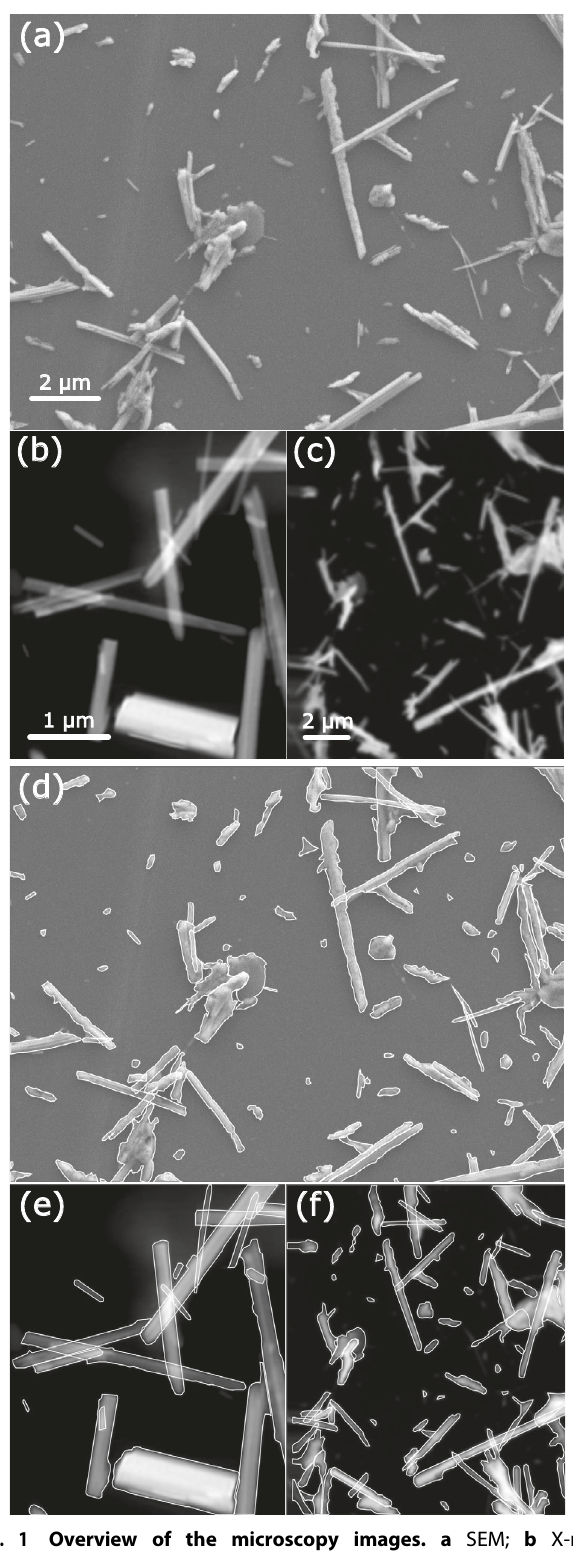
Fig. 1 Overview of the microscopy images. a SEM; b X-ray ptychography; c STXM; d – f corresponding manual